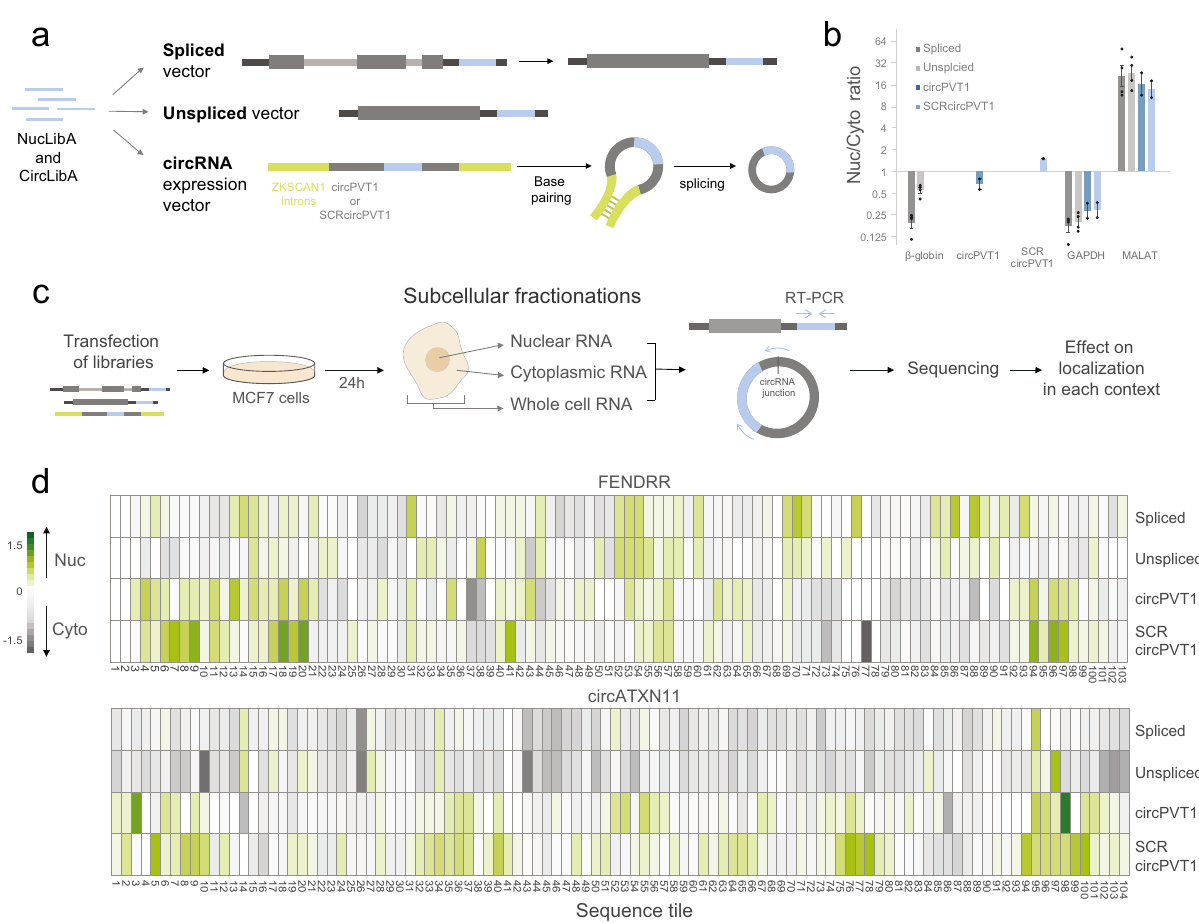
Fig. 1 MPRNA for localization using different forms of RNA. a CircLibA and NucLibA were cloned into four expression vectors; in the 3 ′ UTR of WT β - globin (spliced) and β -globin- Δ introns (unspliced), and in the middle of circPVT1 or SCRcircPVT1 (circular). b qPCR analysis of nuclear and cytoplasmic fractions following transfection of β -globin plasmids or circular expression vectors. n = 4 biologically independent samples, n = 2 for circular expression vectors. Data are presented as mean values + / − SEM. c Outline of the experimental procedure; libraries were transfected, and cells were fractionated into nuclear and cytoplasmic fractions after 24 h. Libraries for sequencing were generated from total, nuclear and cytoplasmic RNA. d Subcellular localization of the tiles derived from the lncRNA FENDRR and the circRNA circATXN11 in the spliced, unspliced, circPVT1, and SCRcircPVT1 contexts. Color indicates the log 2 (Nuc/Cyto) of each tile. Cytoplasmic shift is in gray, nuclear shift in green. Source data are provided as a Source data fi